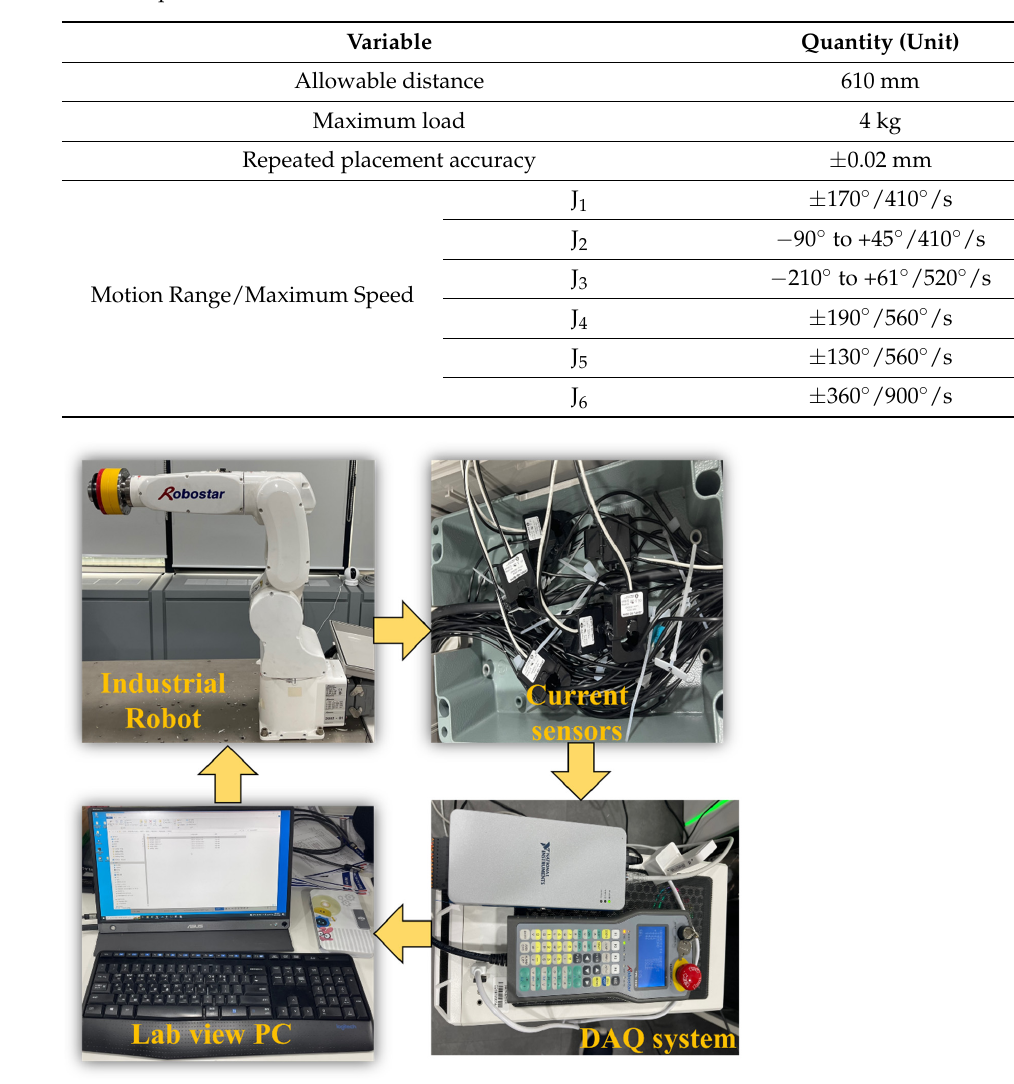
Figure 2. Demonstration of the experimental system.